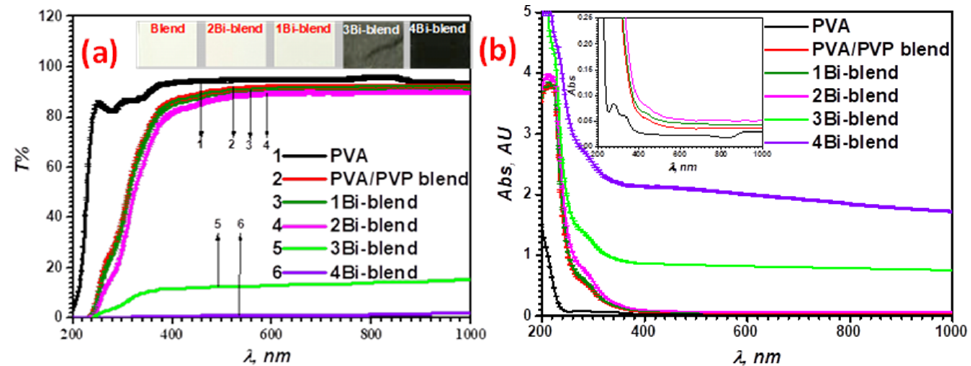
Figure 5. UV–Vis-NIR spectra of pristine PVA, PVP/PVA blend, and Bi-blend hybrid films ( a ) transmittance and ( b ) absorbance.